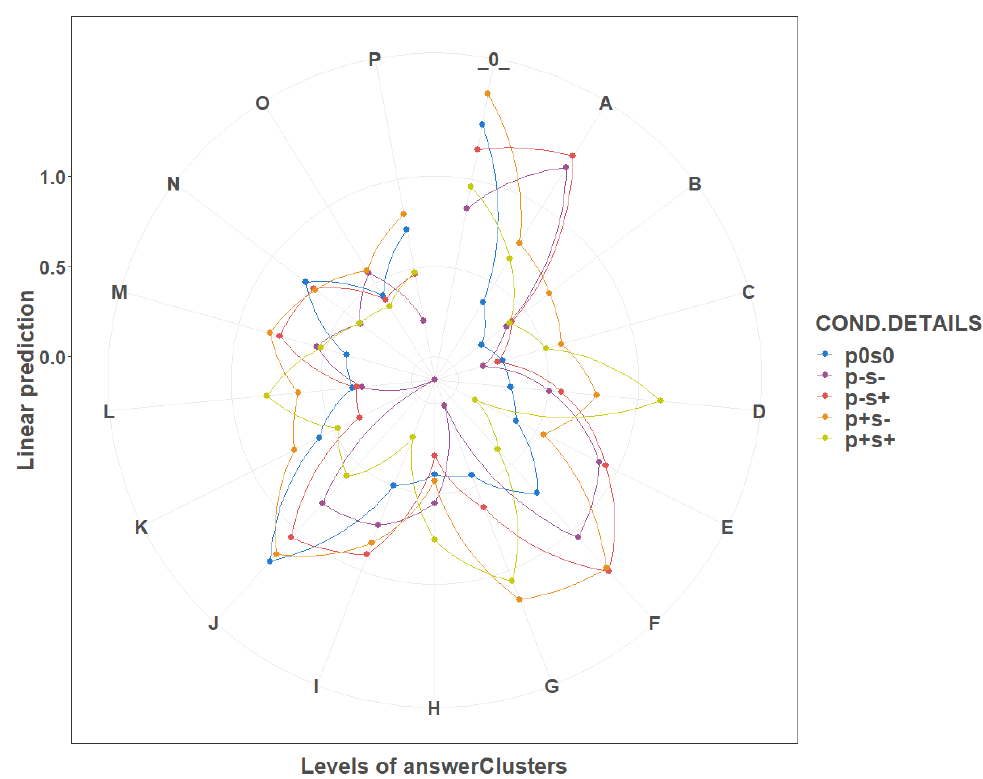
Figure 10. Mixed model of the influence of specific stimuli conditions on the emospace widget